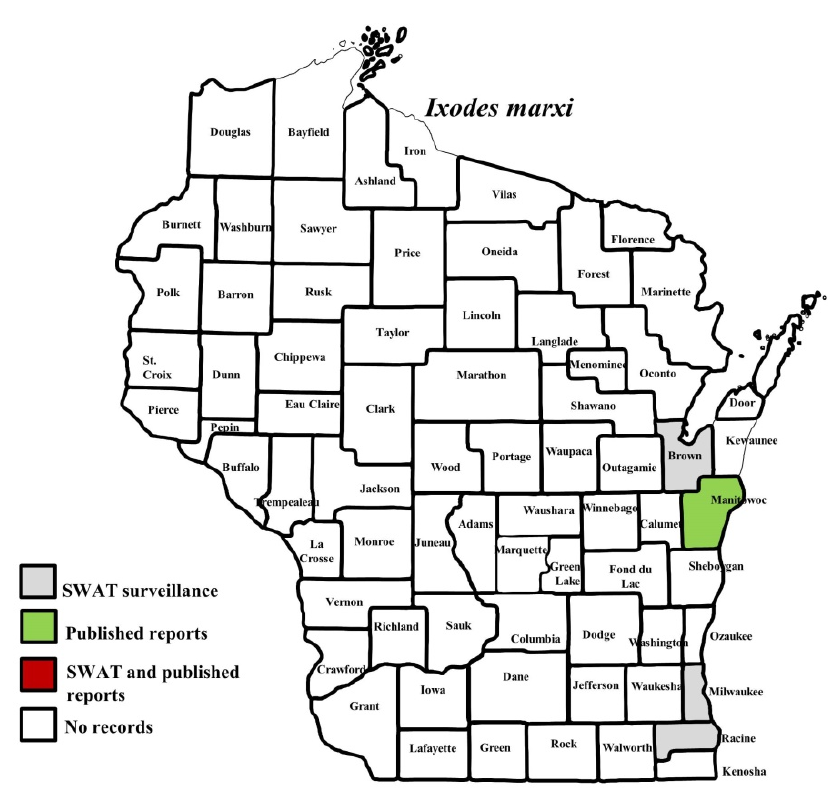
Figure 6. County records for Ixodes marxi in Wisconsin [27].